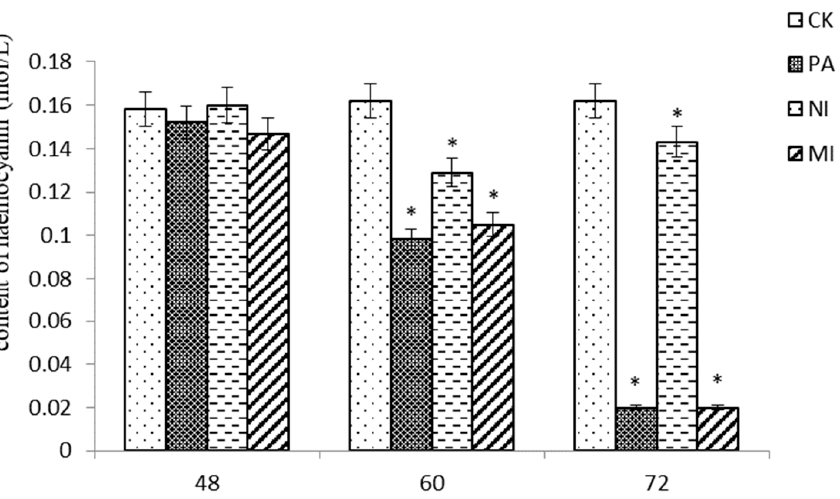
Figure 5. The effect of different treatments on the hemocyanin content in hemocytes, *— p < 0.05.